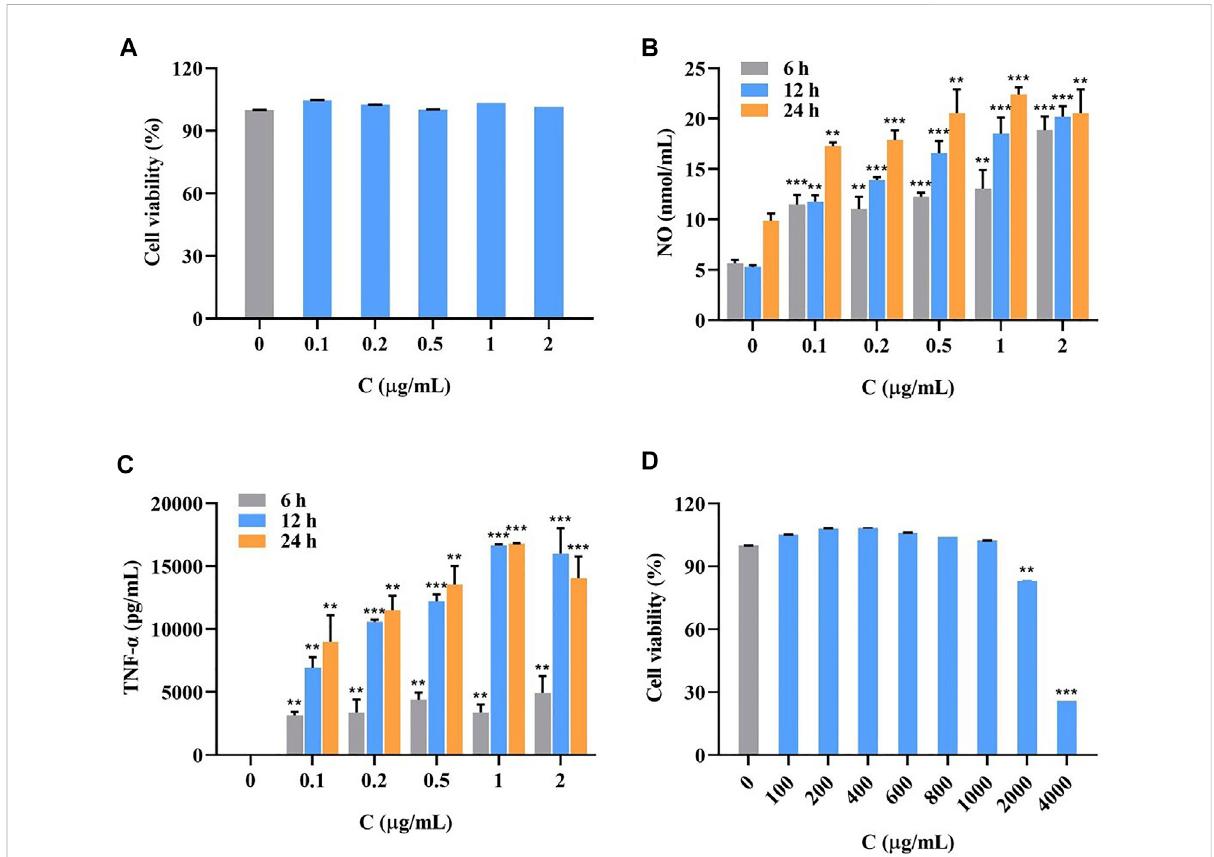
FIGURE 3 Survival rate of LPS-induced RAW264.7 cells at LPS different concentrations for 24 h (A) , the accumulation of NO (B) and TNF- α (C) in LPS- induced RAW264.7 cells at different concentrations for 6, 12 and 24 h ( (cid:1) x ± SD, n = 3, nmol/mL), and survival rate of RAW264.7 cells after the addition of I. cappa extract (D) . Compared with the blank group, *p < 0.05, **p < 0.01, ***p <